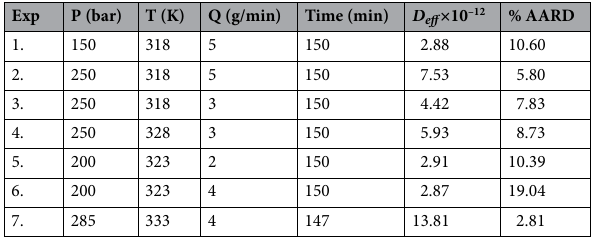
Table 7. Results of single sphere